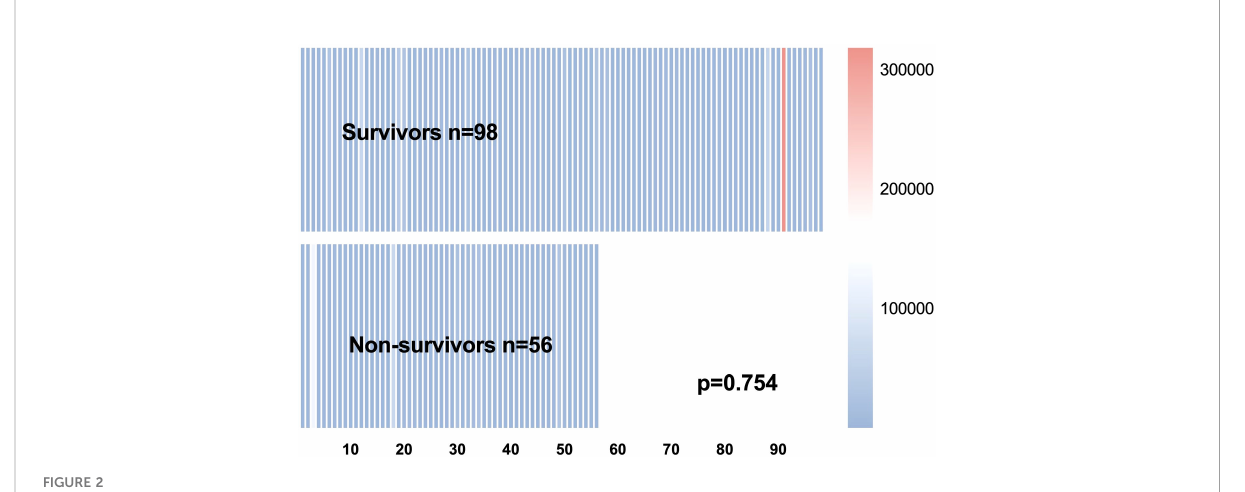
FIGURE 2 The heatmap of the reads